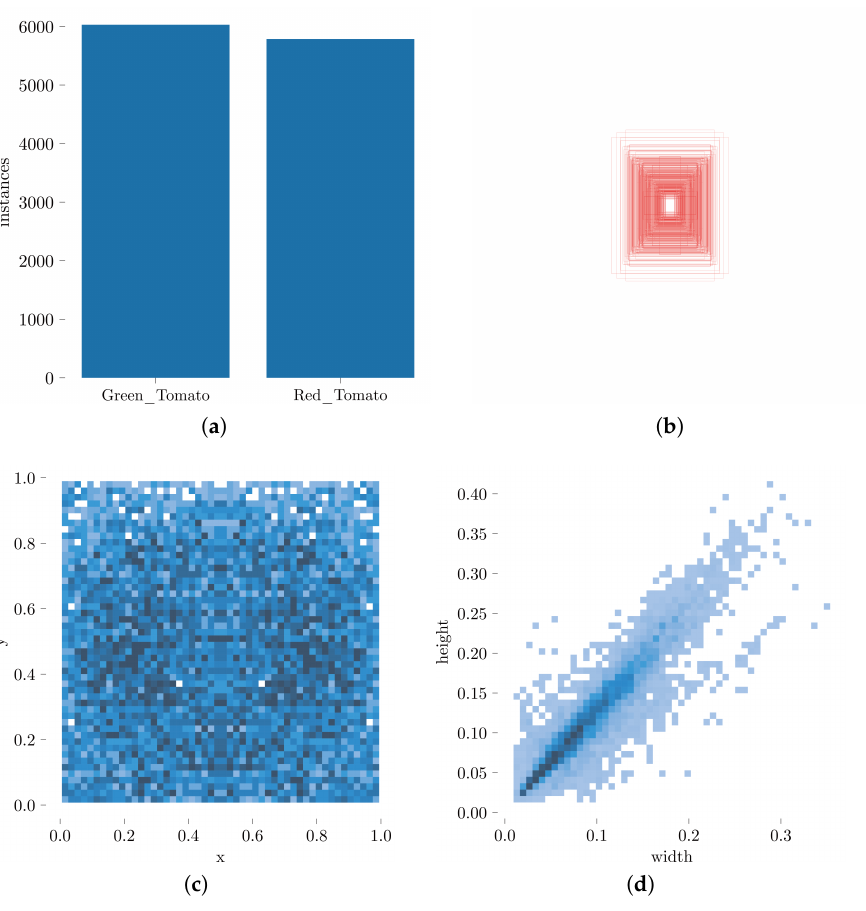
Figure 1. Attribute visualization results of the dataset in this study: ( a ) the number of dataset labels,